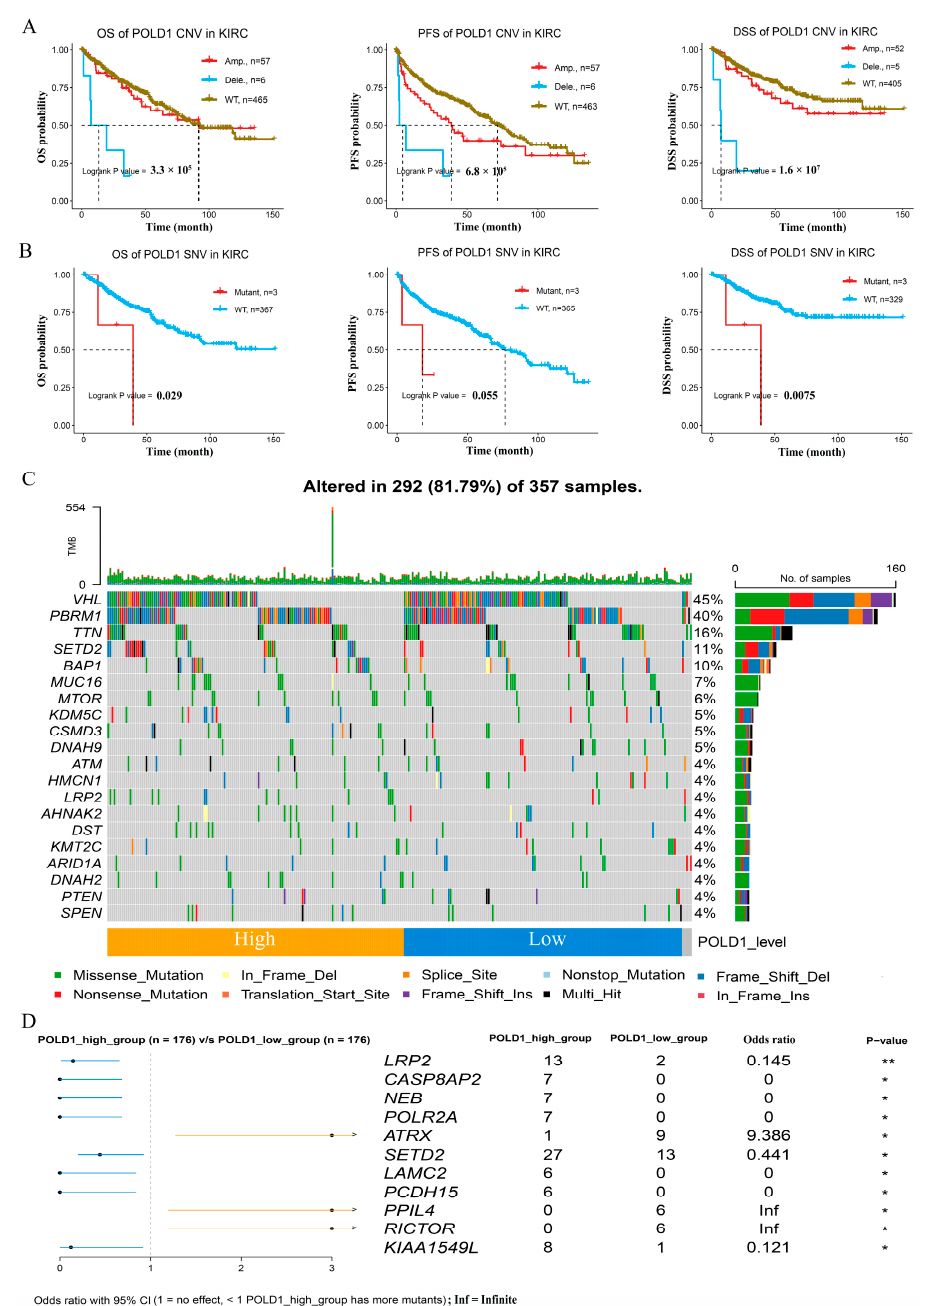
Figure 3. Relationship between somatic mutations and POLD1 expression in ccRCC patients. ( A ) Kaplan–Meier survival curves show the association between the CNV of the POLD1 gene with the OS, PFS, and DSS rates in ccRCC patients. ( B ) Kaplan–Meier survival curves show the association between the SNV of the POLD1 gene and overall survival (OS), progression-free survival (PFS), and disease-specific survival (DSS) in ccRCC patients. ( C ) Somatic mutations in the POLD1-high and POLD1-low expression groups. ( D ) Comparison of the mutations between the high expression and low expression groups of POLD1. * p < 0.05, ** p < 0.01.